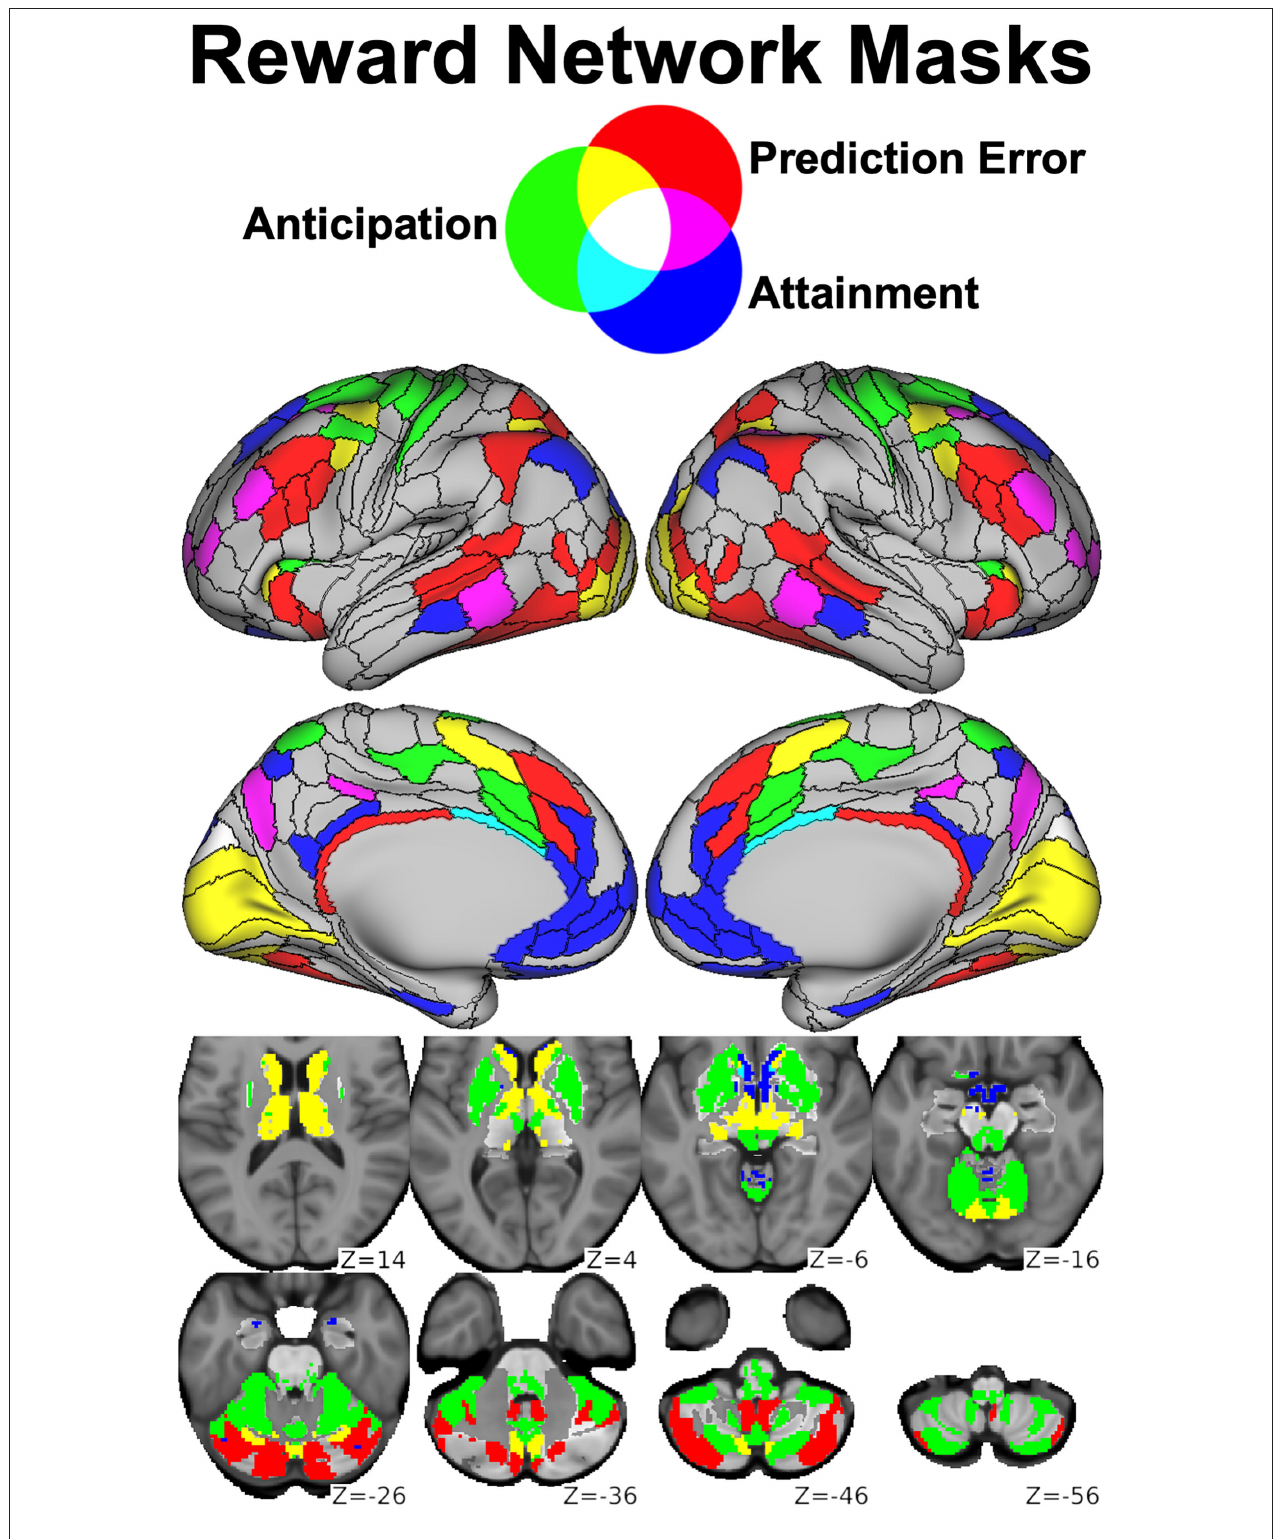
FIGURE 8 | Parcels derived from the Cole-Anticevic Brain-wide Network Partition (black lines) most strongly activated during the RFT by reward anticipation (green), reward attainment (blue), reward prediction errors (red), or some combination thereof (mixed colors) and used as reward networks in our graph theory study. Reprinted from